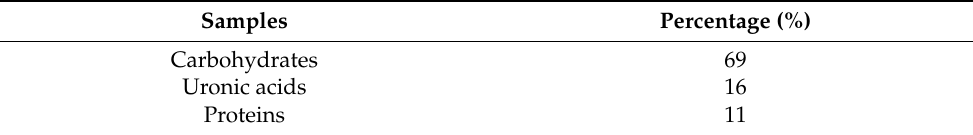
Table 2. Chemical compositions of the purified bioflocculant. Samples Percentage (%)